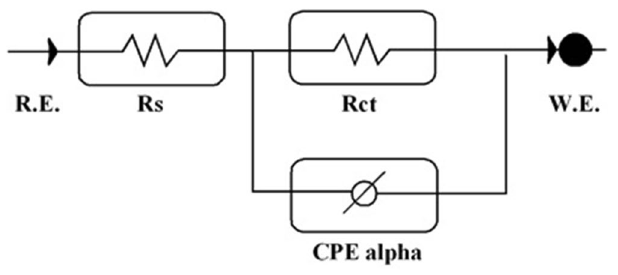
Figure 11. Equivalent circuit model utilised to fit impedance data in 1.0 M HCl with and without the addition of